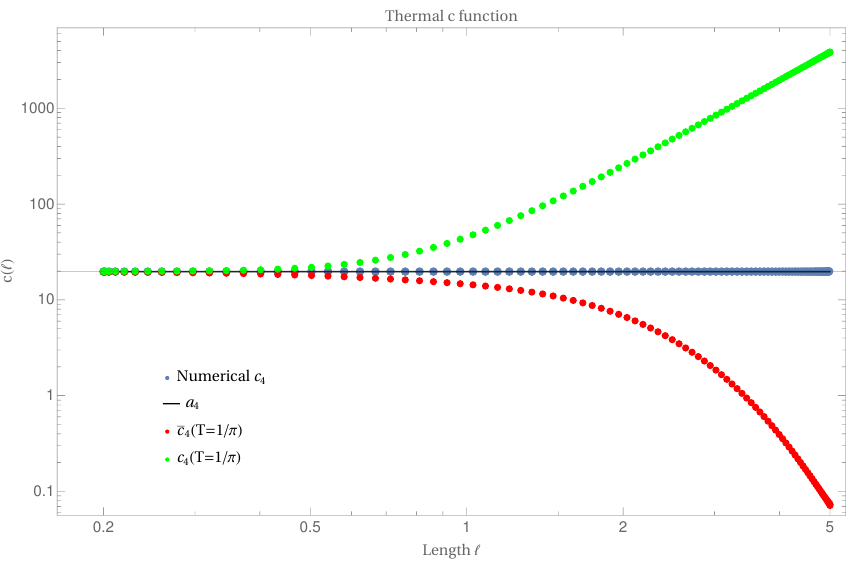
Figure 13 . The c-function as calculated in a thermal state dual to a Schwarzschild black brane in asymptotically AdS spacetime. While c-function c 4 increases as displayed in green the subtracted c-function ¯ c 4 as displayed in red decreases as we decrease the energy scale we probe.